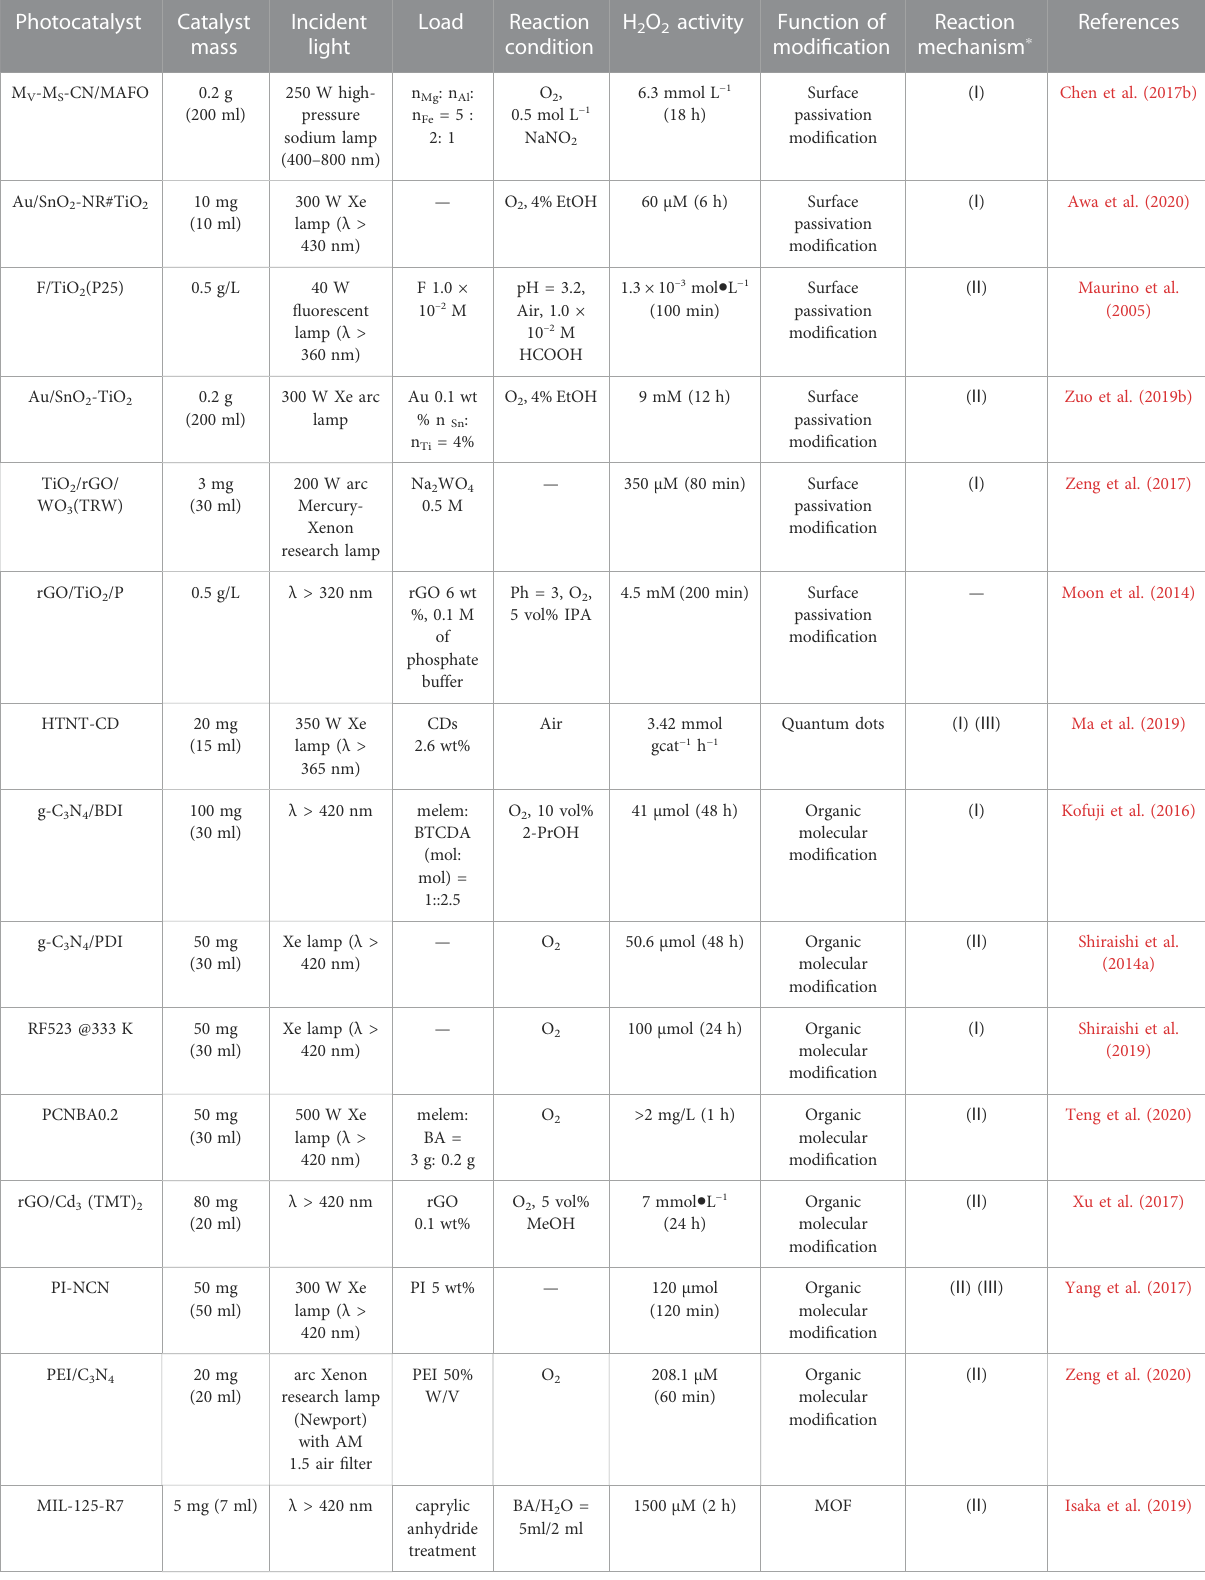
TABLE 2 Activities of photocatalysts with different types of surface modi fi